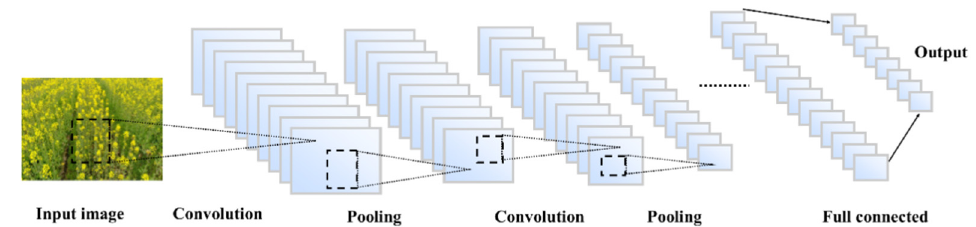
Figure 2. A typical CNN architecture for OSR plant recognition and analysis.